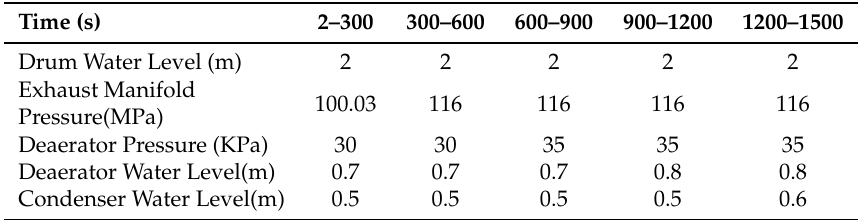
Table 4. Setpoints for different loops in the experiments.